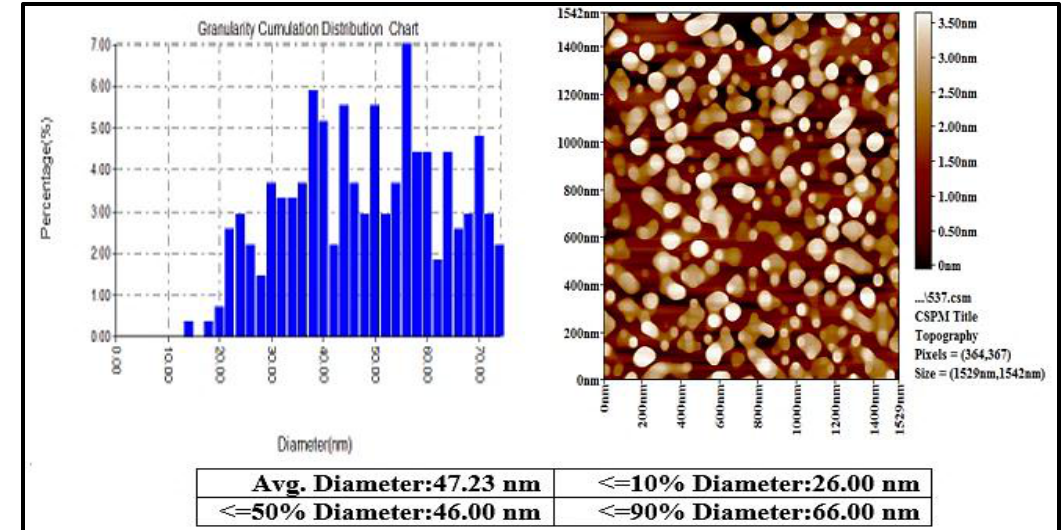
Fig. 1: Particle size and distribution for zirconium oxide nanoparticles (ZrO nanoparticles through Atomic Force Microscope